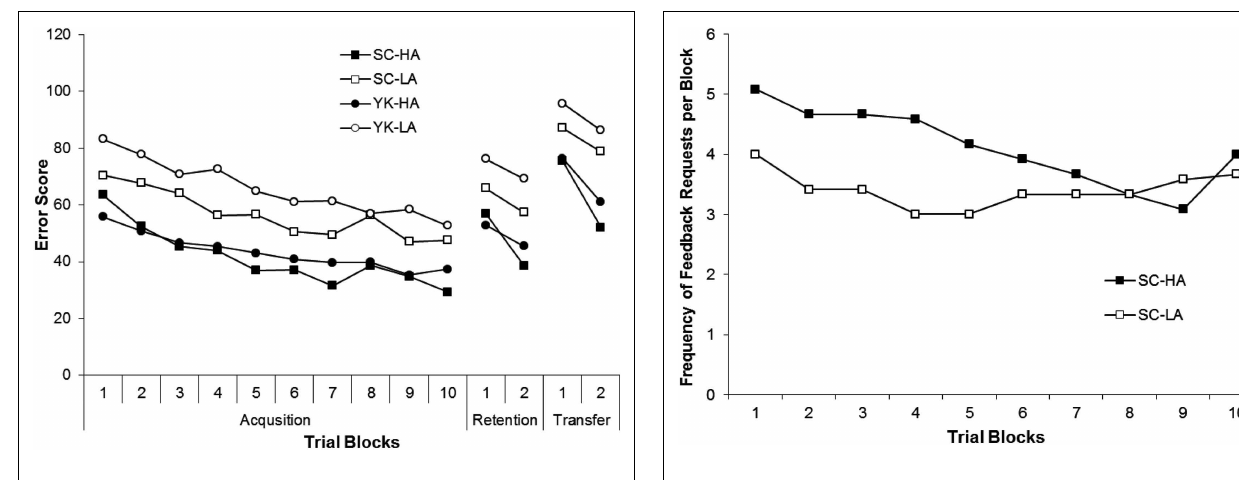
FIGURE 2 | Mean frequency of feedback requests for the Self-Control-HighActivity (SC-HA) and Self-Control-LowActivity (SC-LA) groups during each trial block of acquisition.